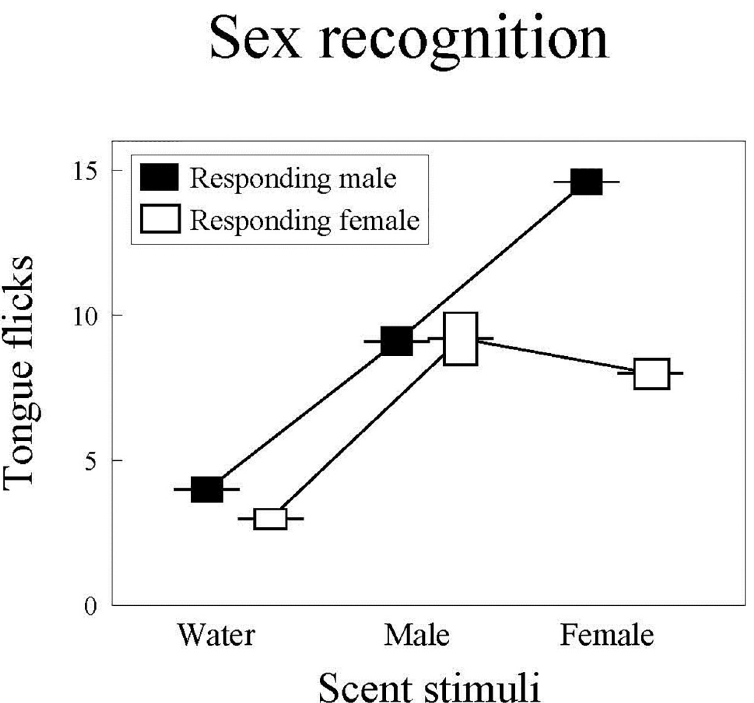
Fig 1. Sex recognition in T . wiegmanni amphisbaenians. Number (mean ± SE) of directed tongue-flicks emitted by male (open boxes) and female (black boxes) amphisbaenians in 60 sec in response to scent stimuli (water or scent of unfamiliar male or female conspecifics) presented on cotton